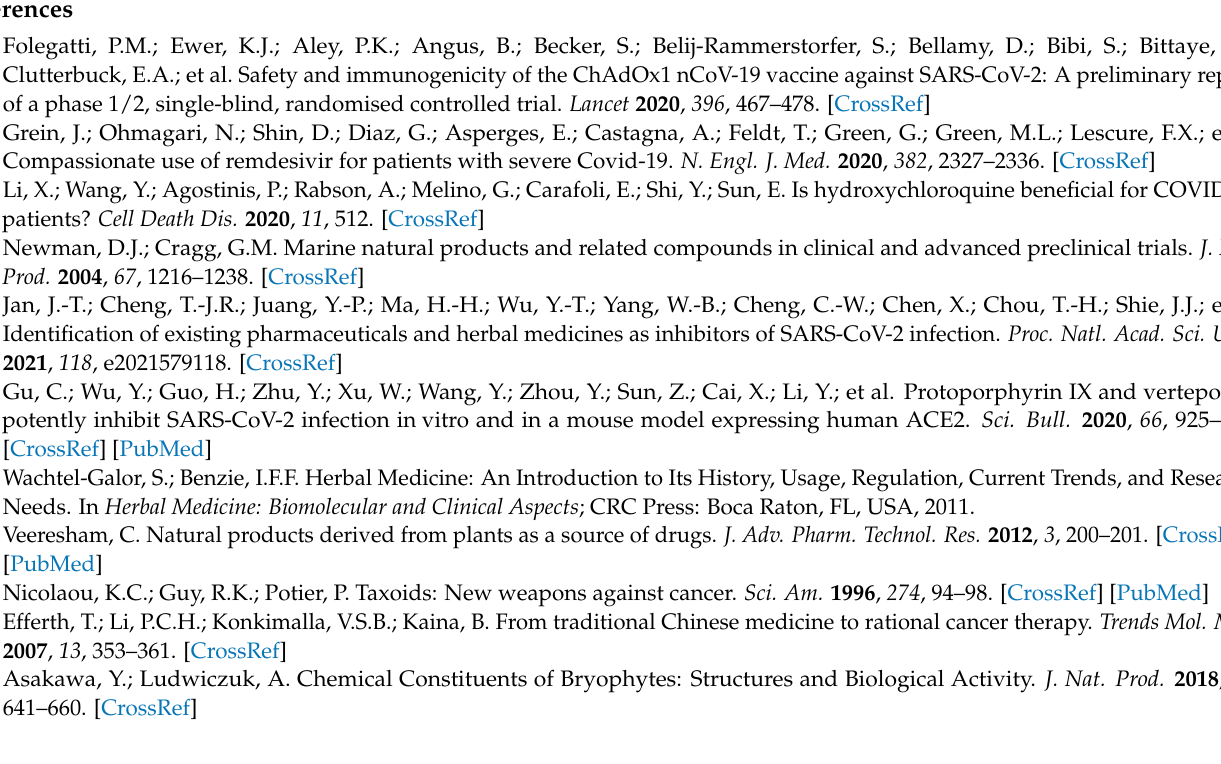
Figure S2: Crude extracts of several plant species show antiviral potential against SARS-CoV-2 infection in cell culture, Figure S3: TLCs of pooled fractions submitted to antiviral assays, Figure S4: Scheme of PheoA preparation from plant material. KG, Silica gel 60, Figure S5: PheoA protects Vero- E6 and human hepatoma Huh7 cells from virus-induced cytopathic effect, Figure S6: Semi-synthetic PheoA preparations display antiviral activity against SARS-CoV-2, Figure S7: Pyropheophorbide a displays antiviral activity against SARS-CoV-2, Figure S8: SARS-CoV-2-pseudotyped retroviral vectors (SARS2pp) are not susceptible to PheoA antiviral